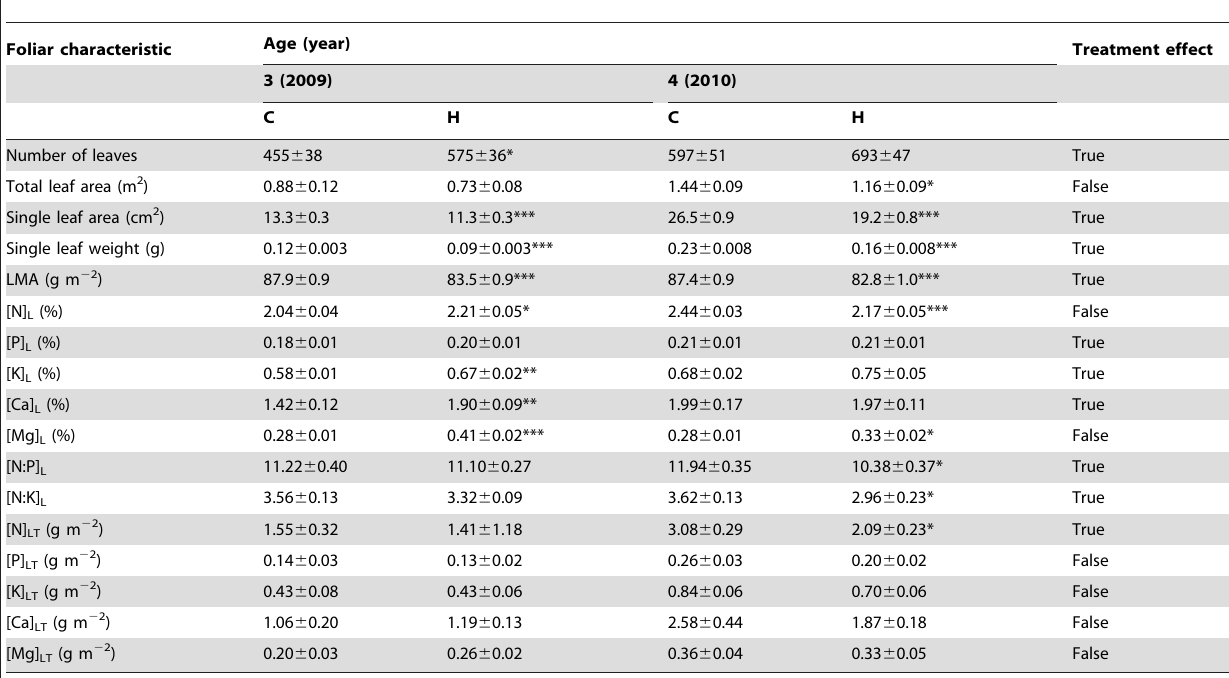
Table 4. Comparison of foliar characteristics (mean 6 standard error) in control (C) and humidified (H) plots during individual study years (asterisks indicate p -values based on t -test: 0.01 , p , 0.05*; 0.001 , p , 0.01**; p , 0.001***) and summary effect of the treatment through the years: ‘‘True’’ if q ,